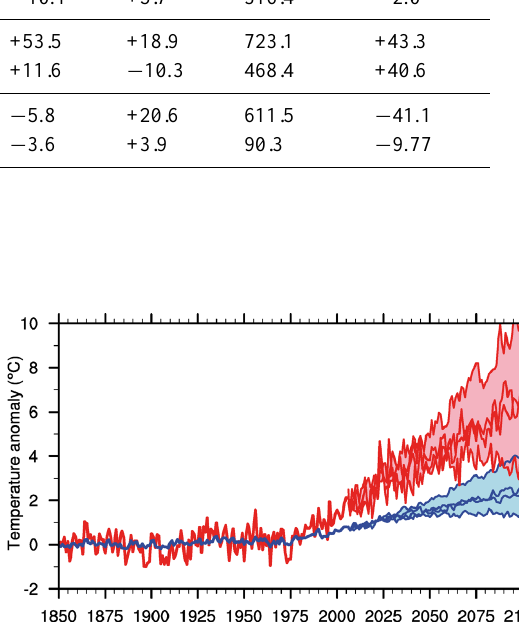
Fig. 6. Model simulated development from 1850 to 2100 in surface air temperature relative to the 1850–1899 average for Historic1 until 2005 followed by a range defined by the four RCP scenario projec- tions. Blue: global data, red: the NH polar area north of 65 ◦ N. The diagram can be compared with Fig. 25 in Bentsen et al.